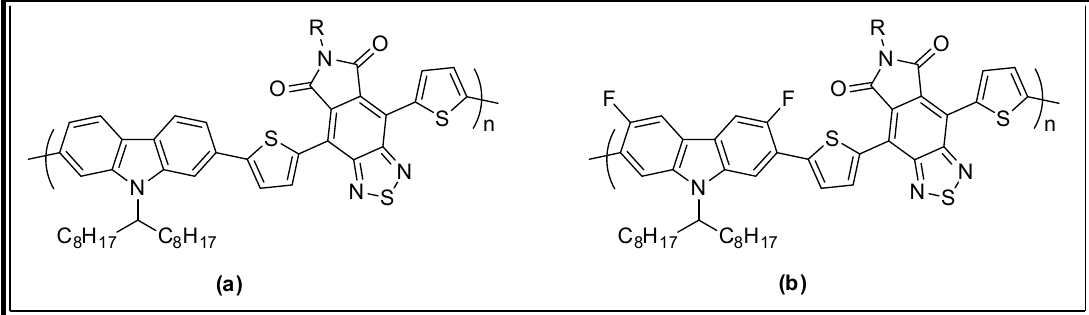
Figure 23. Molecular structures of: ( a ) PCDTBTDI-DMO and PCDTBTDI-8; ( b ) P2F-CDTBTDI-DMO and P2F-CDTBTDI-8 [109].